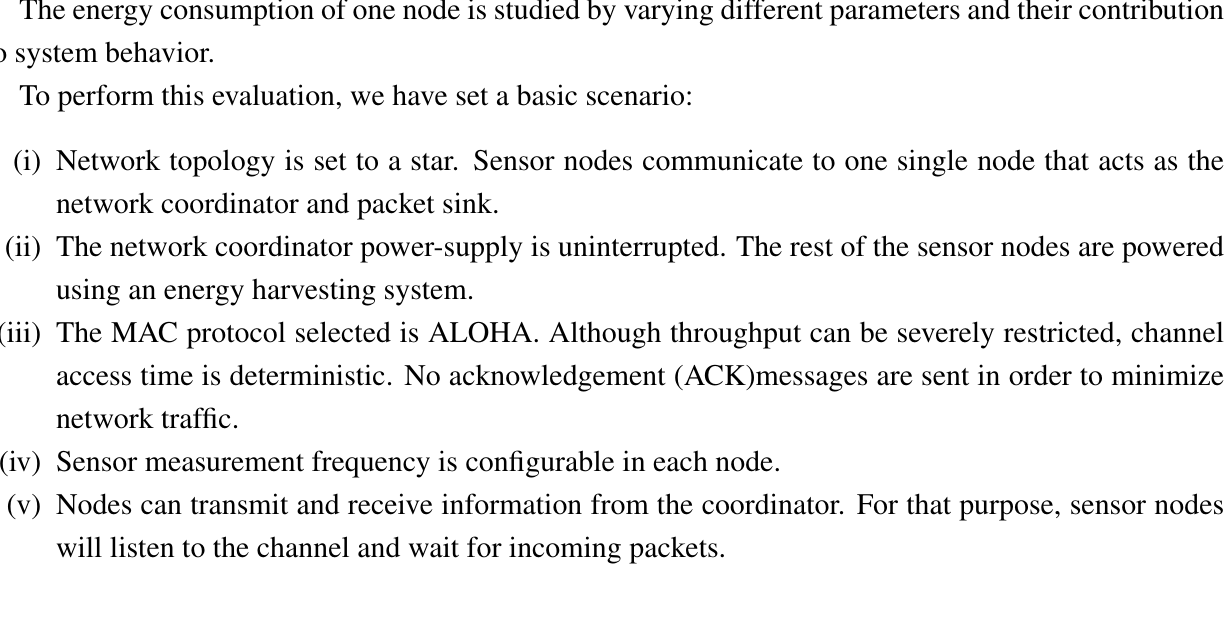
Figure 6. Sensor node simplified state diagram. Remaining time in determined state values are taken from Table 1 and S is the node sleep time (60 s by